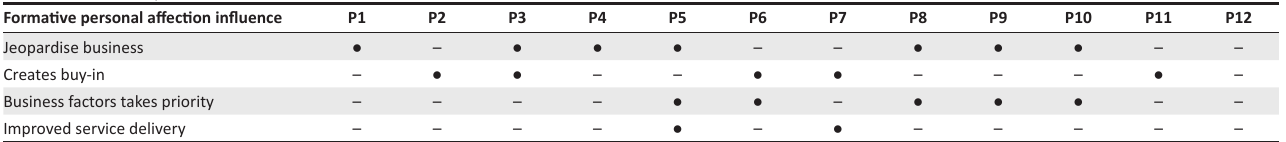
TABLE 5: Formative personal affection